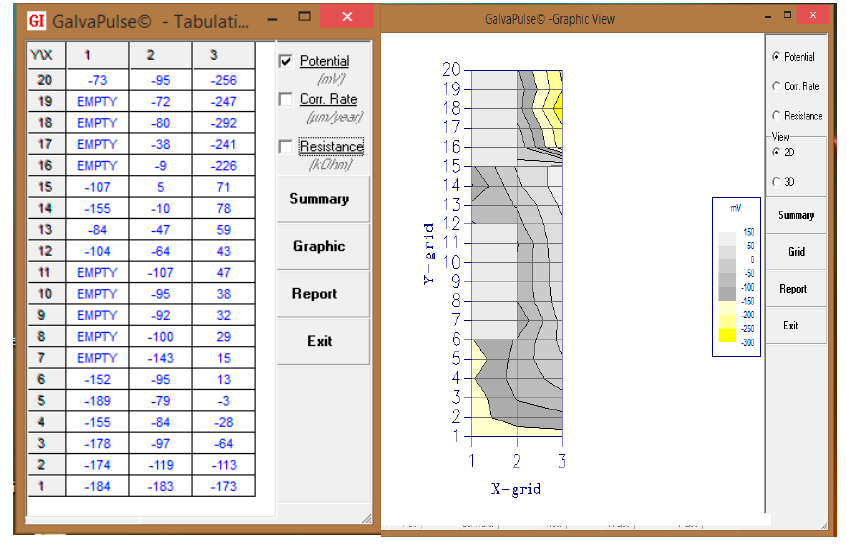
Figure 5. The results of the measurements of reinforcement stationary potential.